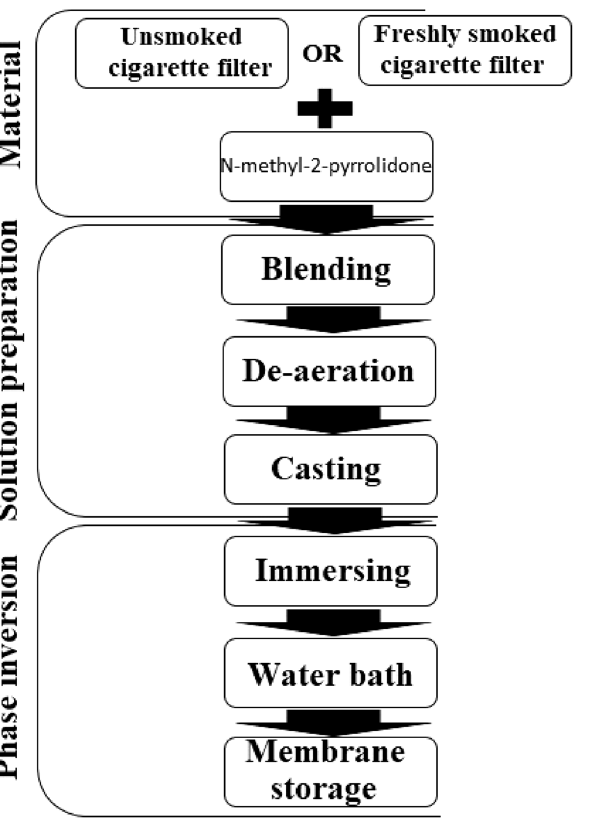
Figure 1. Membrane preparation